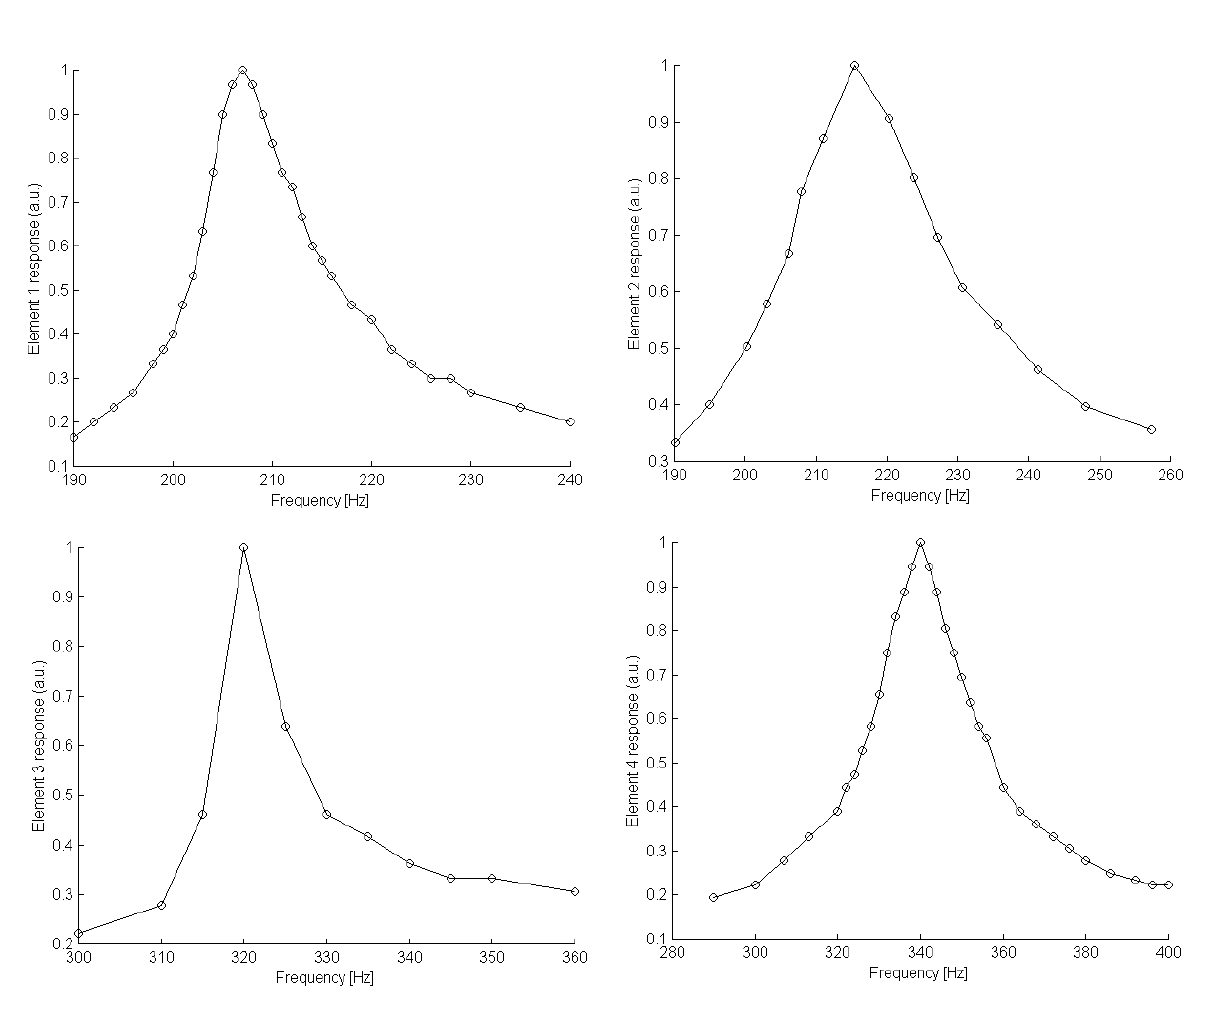
Figure 11. Resonance curves of No1, No2, No3 and No4 tested